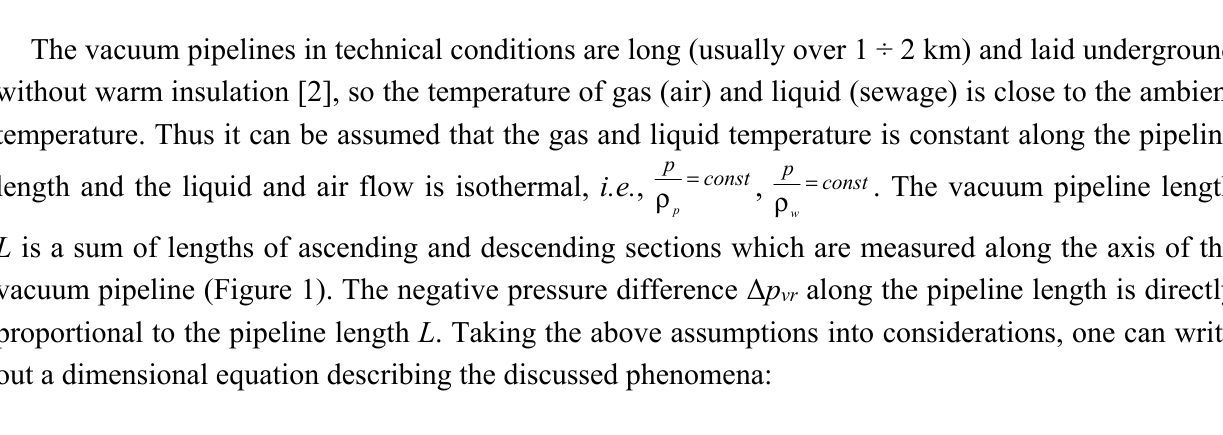
Figure 1. Calculation scheme for derivation of the structural